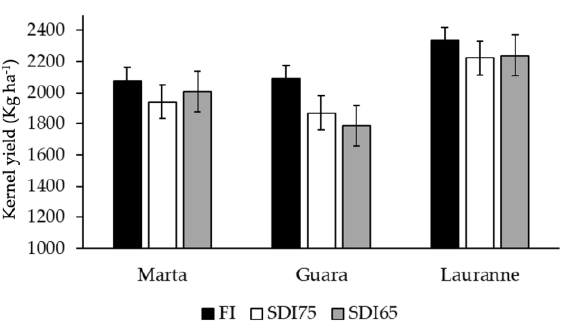
Figure 6. Average kernel yield for the studied almond cultivars during the study. FI, fully irrigated at 100% of irrigation requirements; SDI 75 , irrigated at 75% of the irrigation requirements; SDI 65 , irrigated at 65% of the irrigation requirements. Vertical bars are standard deviation.